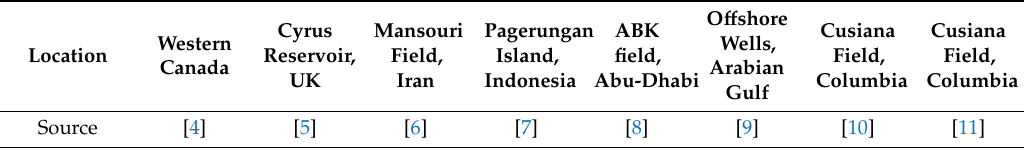
Table 1. In-situ stresses and rock mechanical properties from available literature. Assumed values are